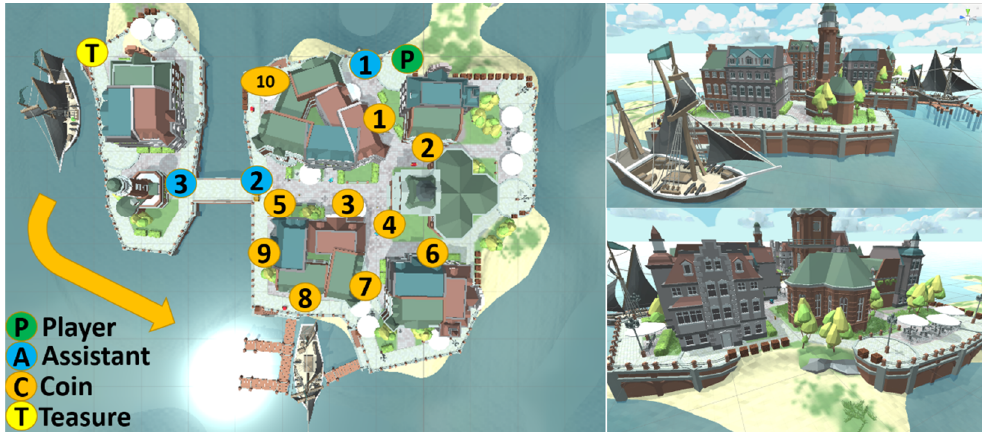
Sensors 2021 , 21 , 3787 20 of 22